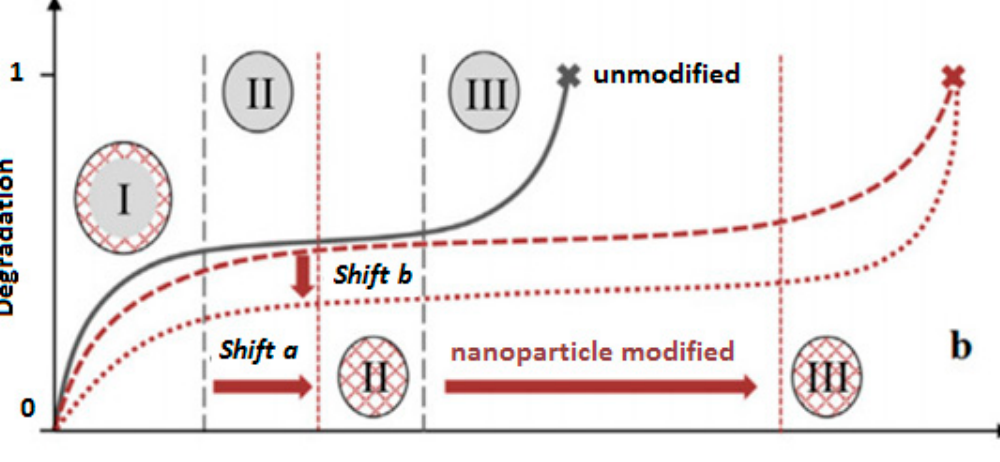
Figure 39. A schematic representation of extending fatigue life of CFRP composite led by adding through an extension of phase I and II (shift a) and a less pronounced degradation increase (shift b), adapted with permission from Ref. [125]. Copyright © 2014 Elsevier